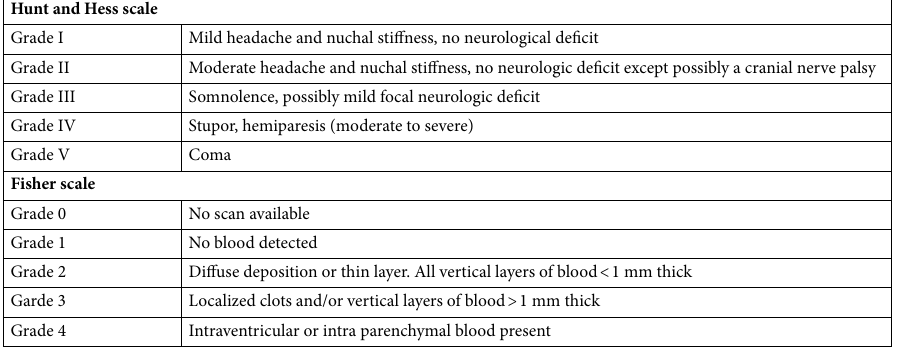
Table 1. The severity of